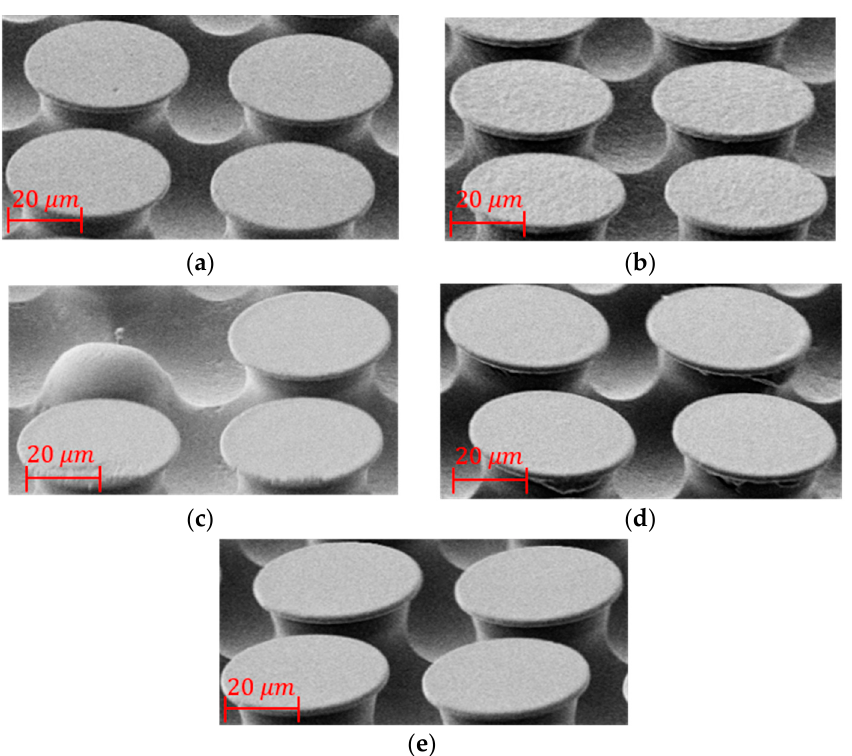
Figure 3. Scanning electron microscope (SEM) samples of polystyrene (PS) replicas from the fluorosilicone mold. ( a ) Duplications from the PS master mold. ( b ) Duplications from the PLA master mold. ( c ) Duplications from the SEBS master mold. ( d ) Duplications from the SMP master mold. ( e ) Duplications from the Sylgard-184 master mold.